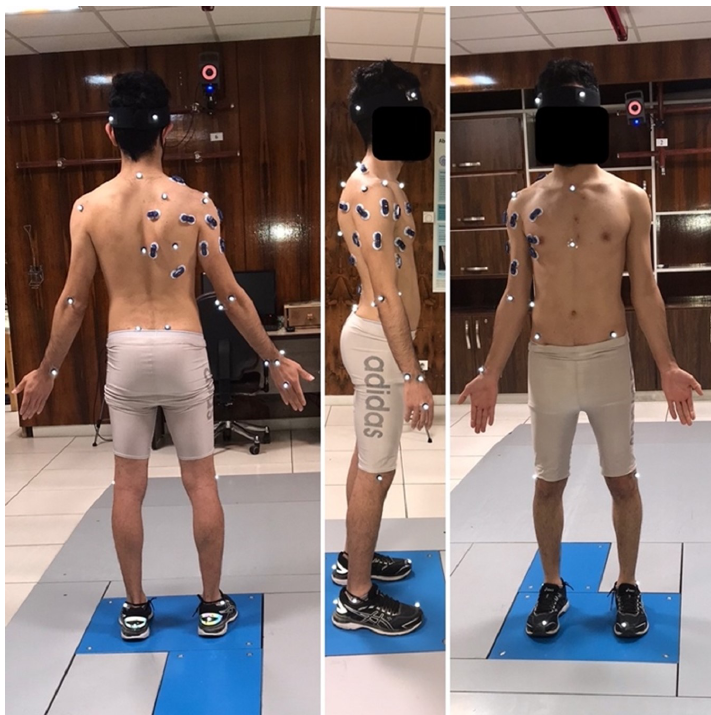
Figure 1. The surface reflective marker and EMG electrode placement for 14 muscles: anterior deltoid, middle deltoid, posterior deltoid, infraspinatus, upper pectoralis major, middle pectoralis major, lower pectoralis major, latissimus dorsi, triceps lateral, triceps medial, biceps brachii, upper trapezius, middle trapezius, and lower trapezius muscles in the motion analysis lab with ten high-speed motion Vicon cameras (Vicon Industries Ltd., Hampshire,